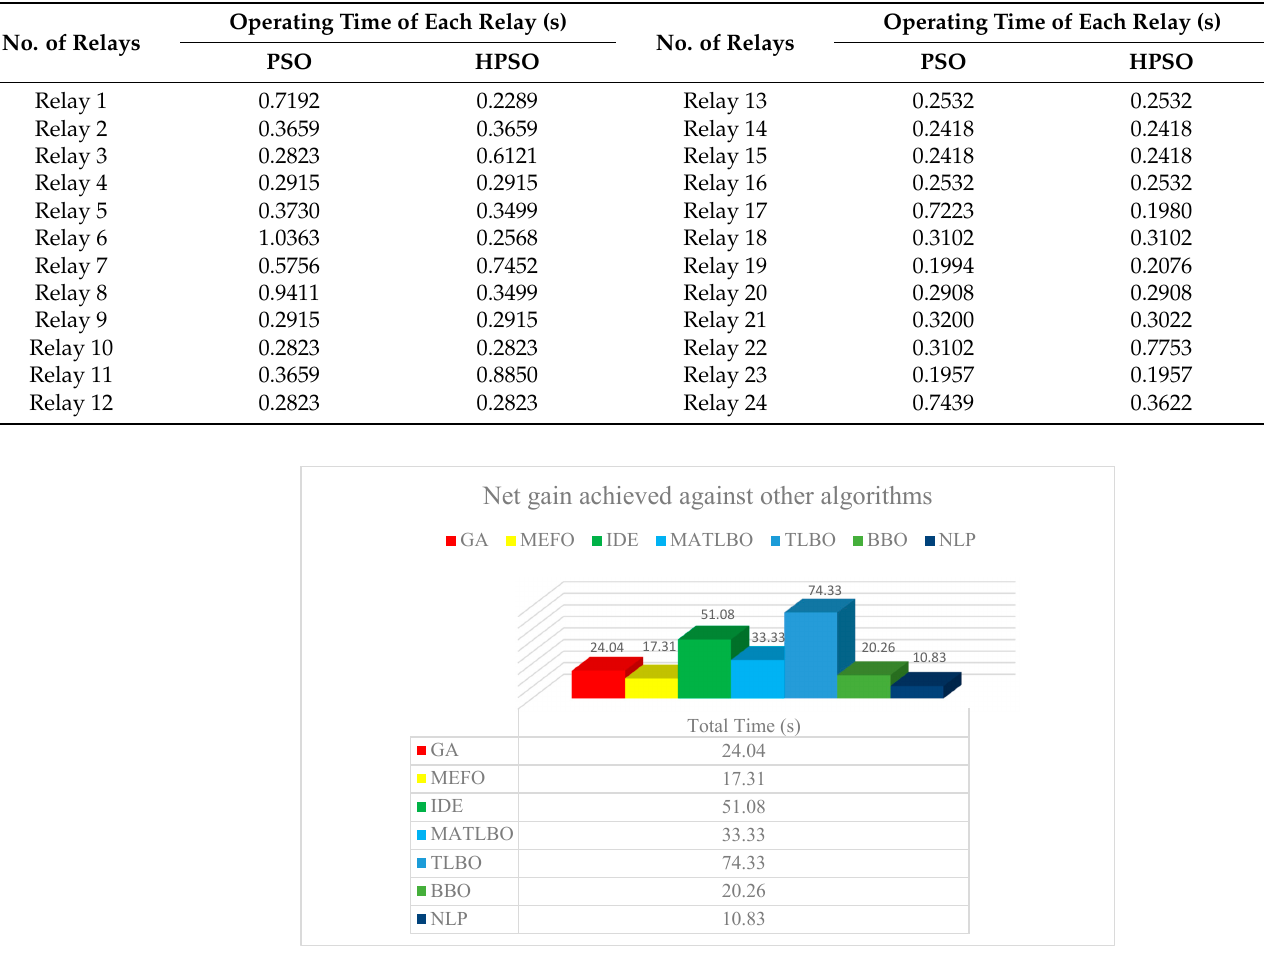
Figure 4. PSO and HPSO convergence characteristics of IEEE 9-Bus system. 4.2. Case 2: IEEE 14-Bus System The IEEE 14-bus system is shown in Figure 5, which consists of one DG, 3 generators, 20 fault points (L1, L2, L3, …, L20), 14 buses (Bus 1, Bus 2, …, Bus 14), and 40 relays (R1, R2, R3, …, R24). There are 92 combinations among these 40 primary–backup relays. One DG is connected at bus 14 and three generators are connected at buses 1, 2, and 6, respec- tively. The current transformer ratios (CTR) for all the relays for this bus system are given